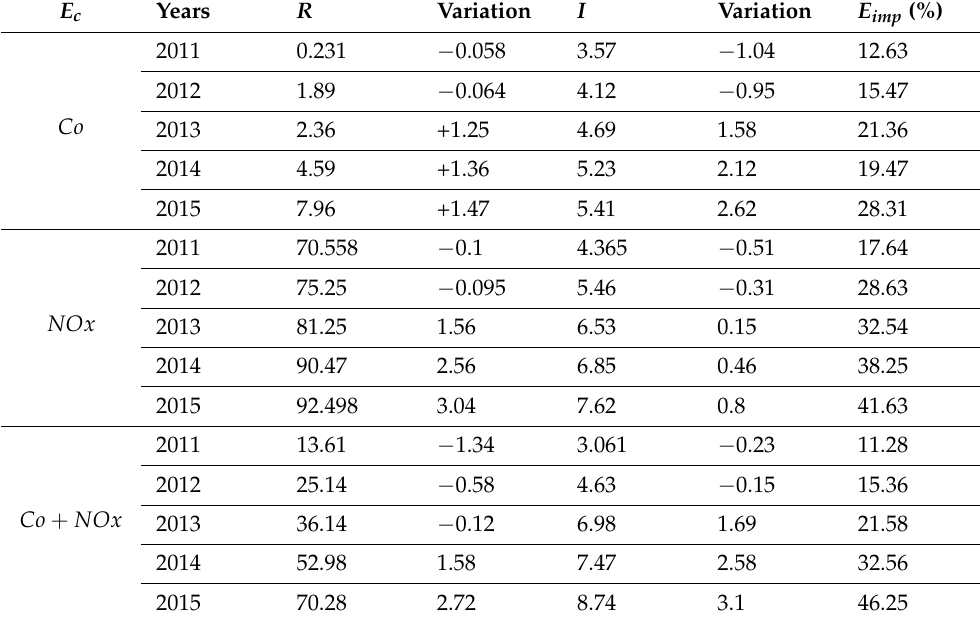
Table 1. Adverse Environmental Impact E imp for Carbon Monoxide Co and Nitric Oxide NO X . E c Years R Variation I Variation E imp (%)